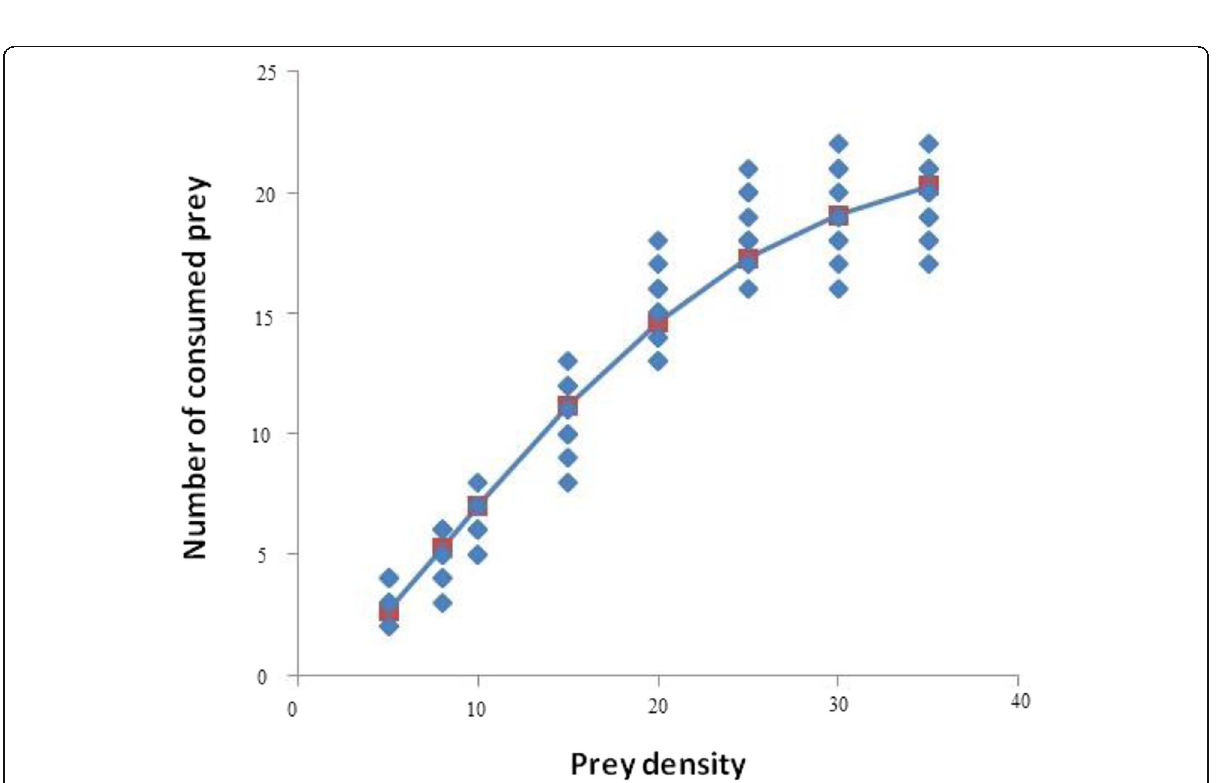
Fig. 2 Mean number of Bemisia tabaci third instar nymphs preyed upon by females of Orius albidipennis in 24 h as a function of nymph